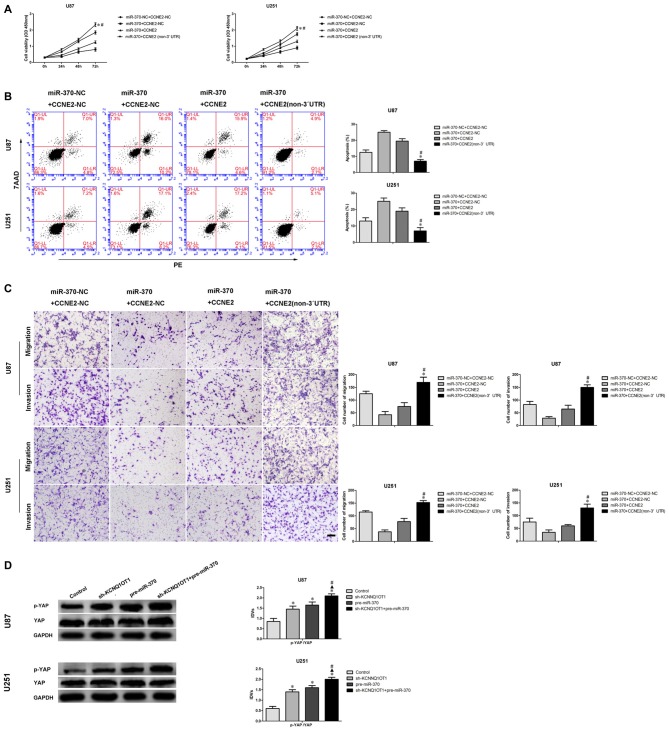
MiR-370 inhibited human glioma cells malignant progression via targeting to CCNE2 3′-UTR. CCNE2 activated the YAP1 signal pathways. (A) CCK-8 assay was used to evaluate the proliferation effect of miR-370 and CCNE2 changed on human glioma cells at 24 h, 48 h and 72 h. (B) Flow cytometry analysis of human glioma cells with the expression of miR-370 and CCNE2 changed. (C) Quantification of migration and invasion cells with the expression of miR-370 and CCNE2 changed. Representative images and accompanying statistical plots were presented. Data are presented as the mean ± SD (n = 5, each group). *#P < 0.05 vs. miR-370 + CCNE2 group. Scale bars represent 20 μm. (D) Western blot analysis of the YES-associated protein (YAP) pathways regulated by CCNE2 in human glioma cells. Data are presented as the mean ± SD (n = 5, each group). *▲#P < 0.05 vs. Sh-KCNQ1OT1 group and pre-miR-370 group.